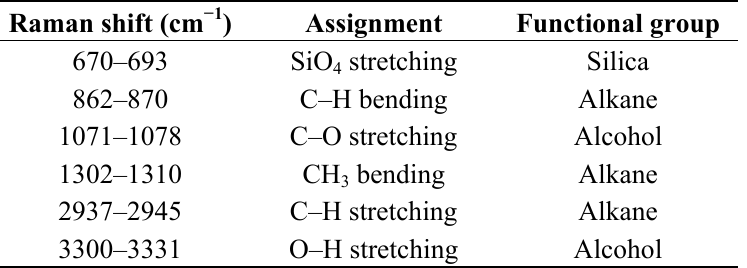
Table 4. The assignment and functional groups of FT-Raman bands of the agarose/talc composite